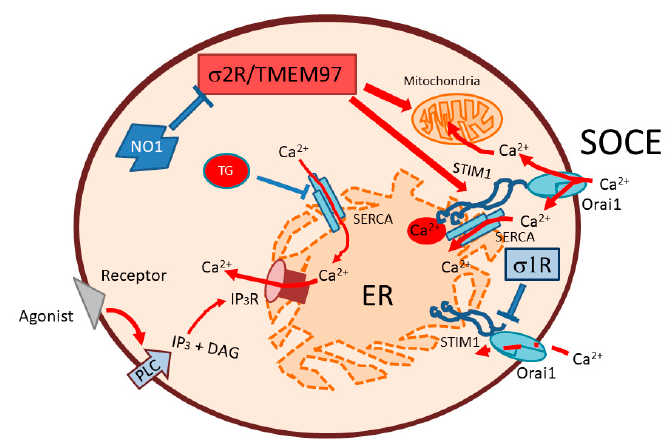
Figure 9. Schematic representation of the σ 2R / TMEM97 regulation of SOCE in MDA-MB-231. SOCE activation in MDA-MB-231 cells may be positively regulated by σ 2R / TMEM97, due to its interaction with STIM1, thereby facilitating its coupling with Orai1. Enhanced SOCE may favor mitochondrial function and cell ATP content, which may lead to enhanced cell proliferation. In contrast, σ 2R / TMEM97 inhibition by NO1 administration may block both SOCE, and may disrupt mitochondria, subsequently activating apoptosis through caspase 9. SOCE: store operated Ca 2 + entry; PLC: phospholipase C; IP 3 : inositol trisphosphate; DAG: diacylglycerol; IP 3 R: inositol trisphosphate receptor. ER: endoplasmic reticulum; SERCA; sarconendoplasmic reticulum Ca 2 + ATPase; TG: thapsigargin.